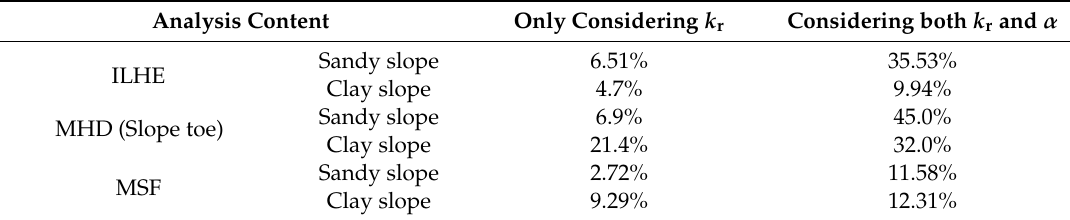
Table 4. Di ff erences between only considering k r and considering both k r and α . Table 4. Differences between only considering k r and considering both k r and α . Analysis Content Only Considering k r Considering both k r and Analysis Content Only Considering k r Considering both k r and α